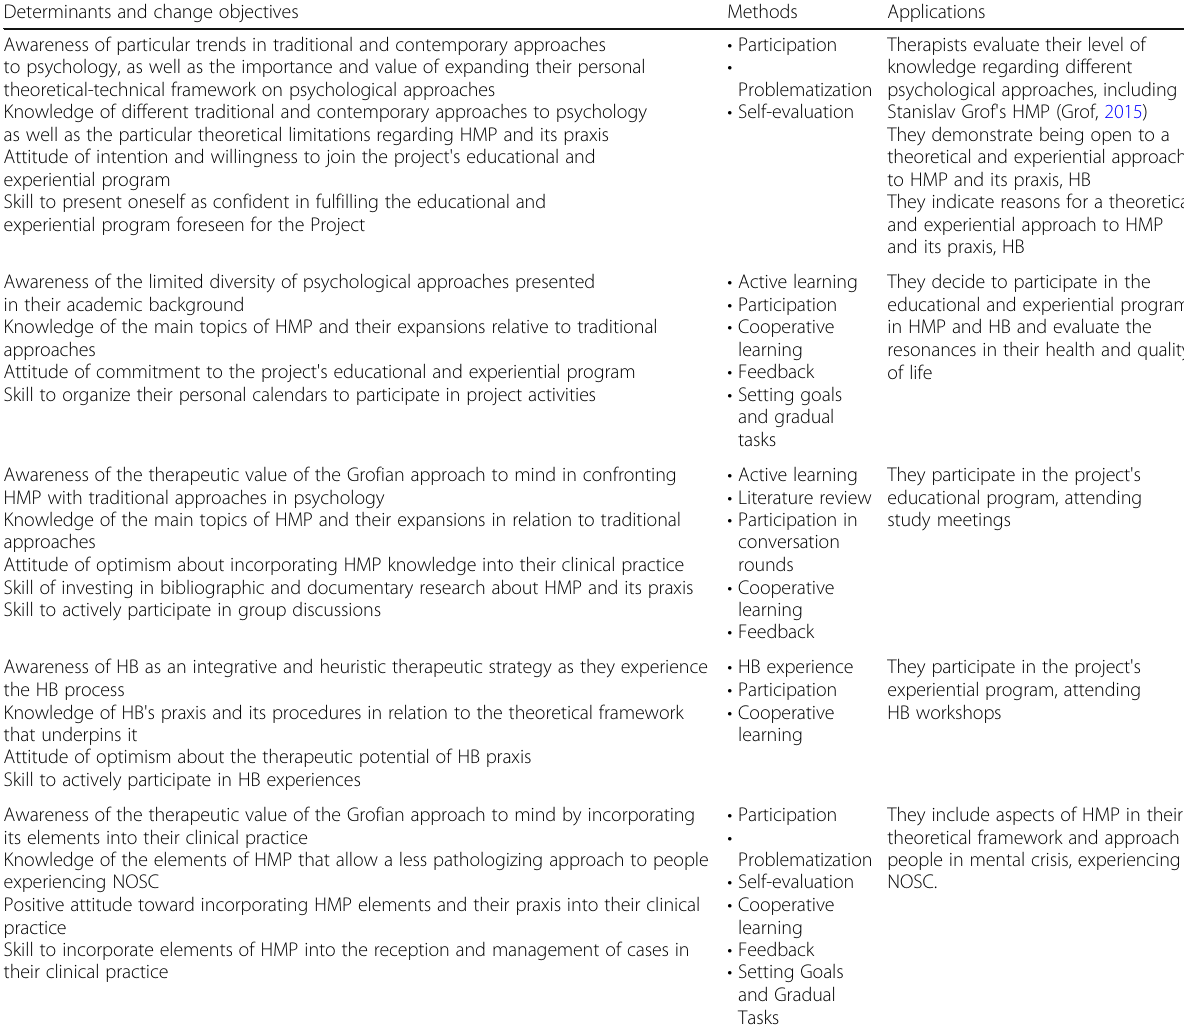
Table 3 Matrix of interactions between determinants, change objectives, methods, and applications Determinants and change objectives Methods